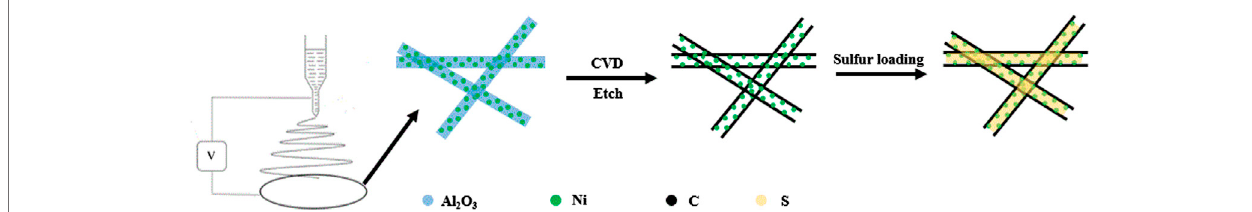
FIGURE 1 | Schematic illustration of the synthesis strategy used to prepare the Ni@HCF/S.